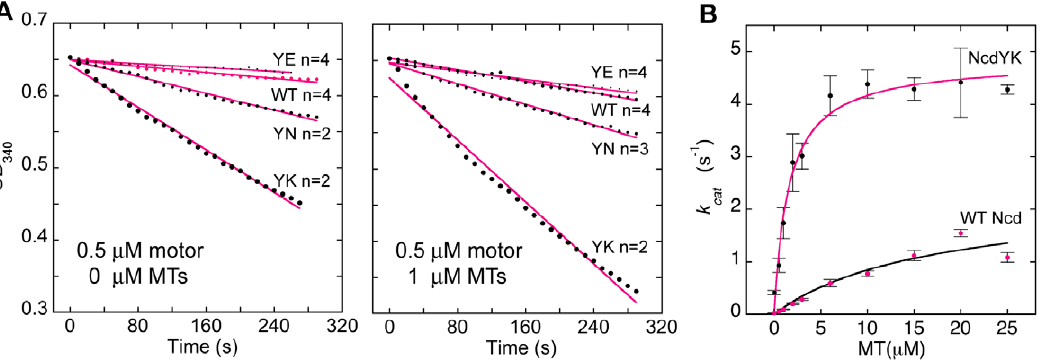
Figure 4. ATP hydrolysis by NcdY485 mutants. (A) Left, basal ATPase activity. Data points adjusted to OD 340 =0.6531 (theoretical starting OD of NADH in reaction mix at t=0) and fit to a line to determine rate of OD 340 decrease due to ATP hydrolysis. Right, microtubule-stimulated ATPase activity with 0.5 m M motor + 1 m M microtubules. (B) NcdYK vs wild-type Ncd ATPase activity. k cat (s 2 1 ) per active site vs [MT]; 0.5 m M motor + 0–25 m M microtubules (n=3). Data points fit to the Michaelis-Menten equation to estimate V max and K M,MT . Mean 6 SEM.